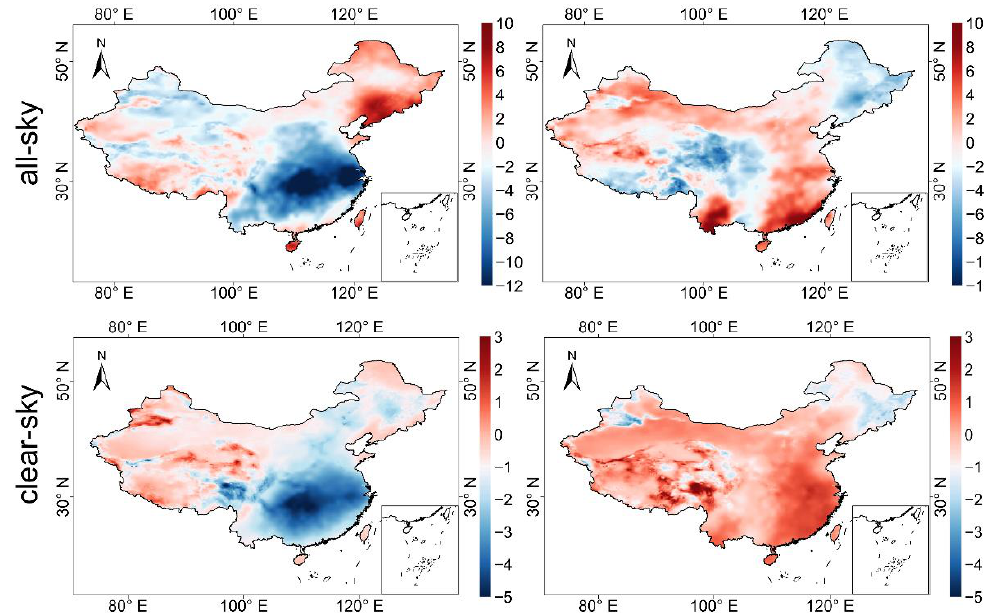
Figure 8. POAI (Wm − 2 ) variation in China during the Air Pollution Prevention and Control Action Plan. The left column is the value of POAI in the OP phase minus the value in the PIP phase, and the right column is the value of POAI in the PCP phase minus the value in the OP phase.